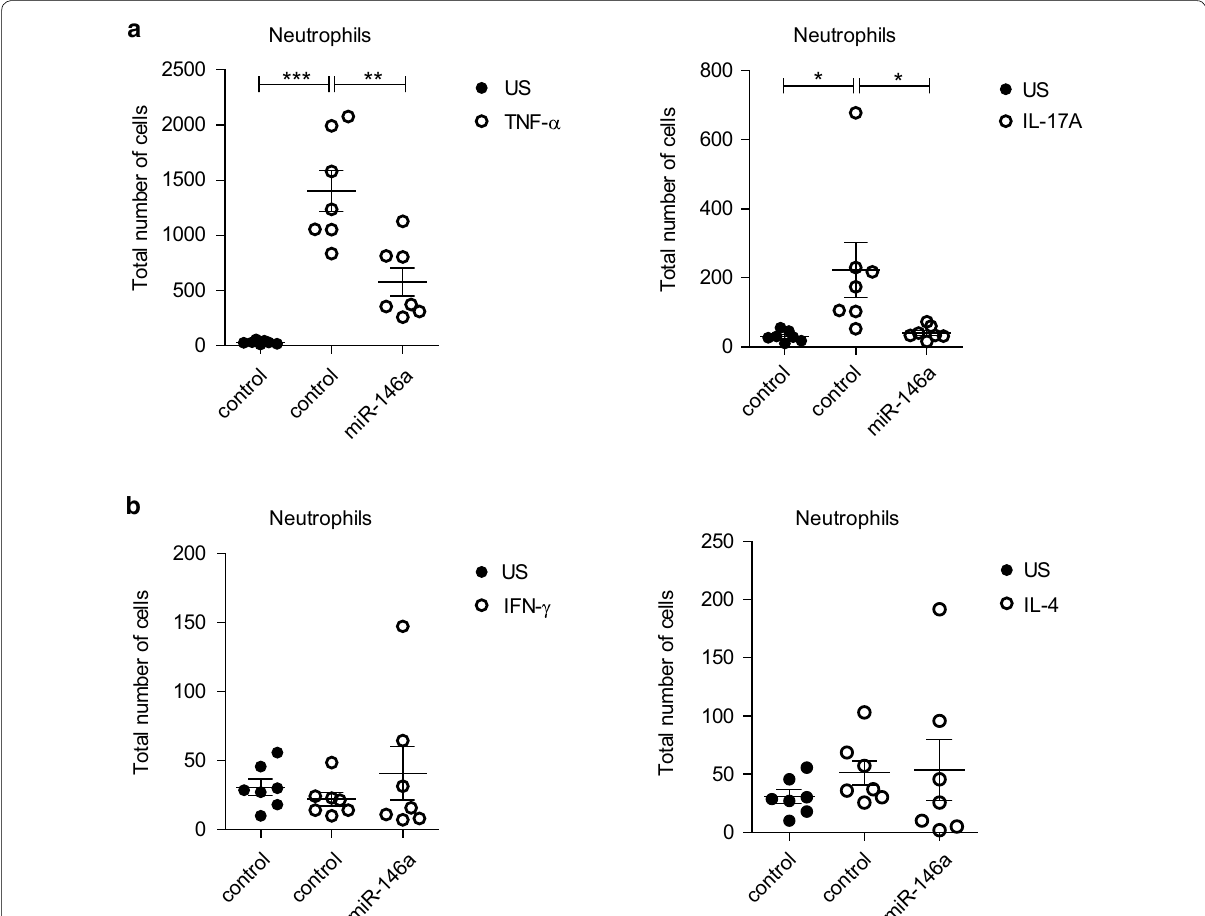
Fig. 5 miR-146a inhibits the expression of secretable factors needed for neutrophil migration. Neutrophil chemotaxis assay was performed using supernatants of HBECs transfected with miR-146a or control mimic and stimulated with indicated cytokines as in Fig. 4. Migrated neutrophils were counted by flow cytometry. Data represent mean SEM. Unpaired t-test, *P < 0.05, **P < 0.01, ***P < ±